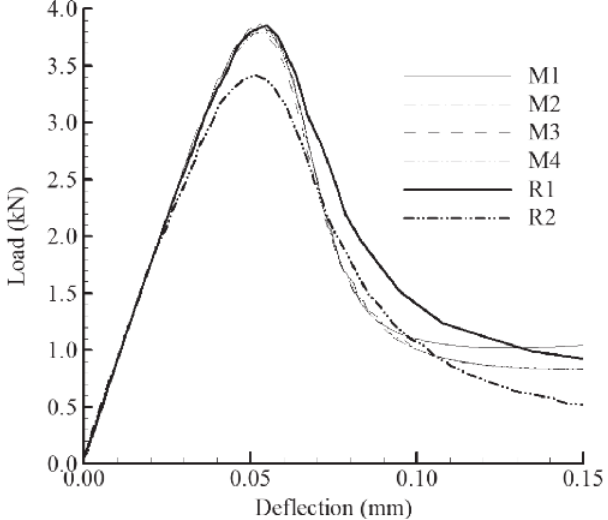
Input parameters for the three-point bending test Geometric